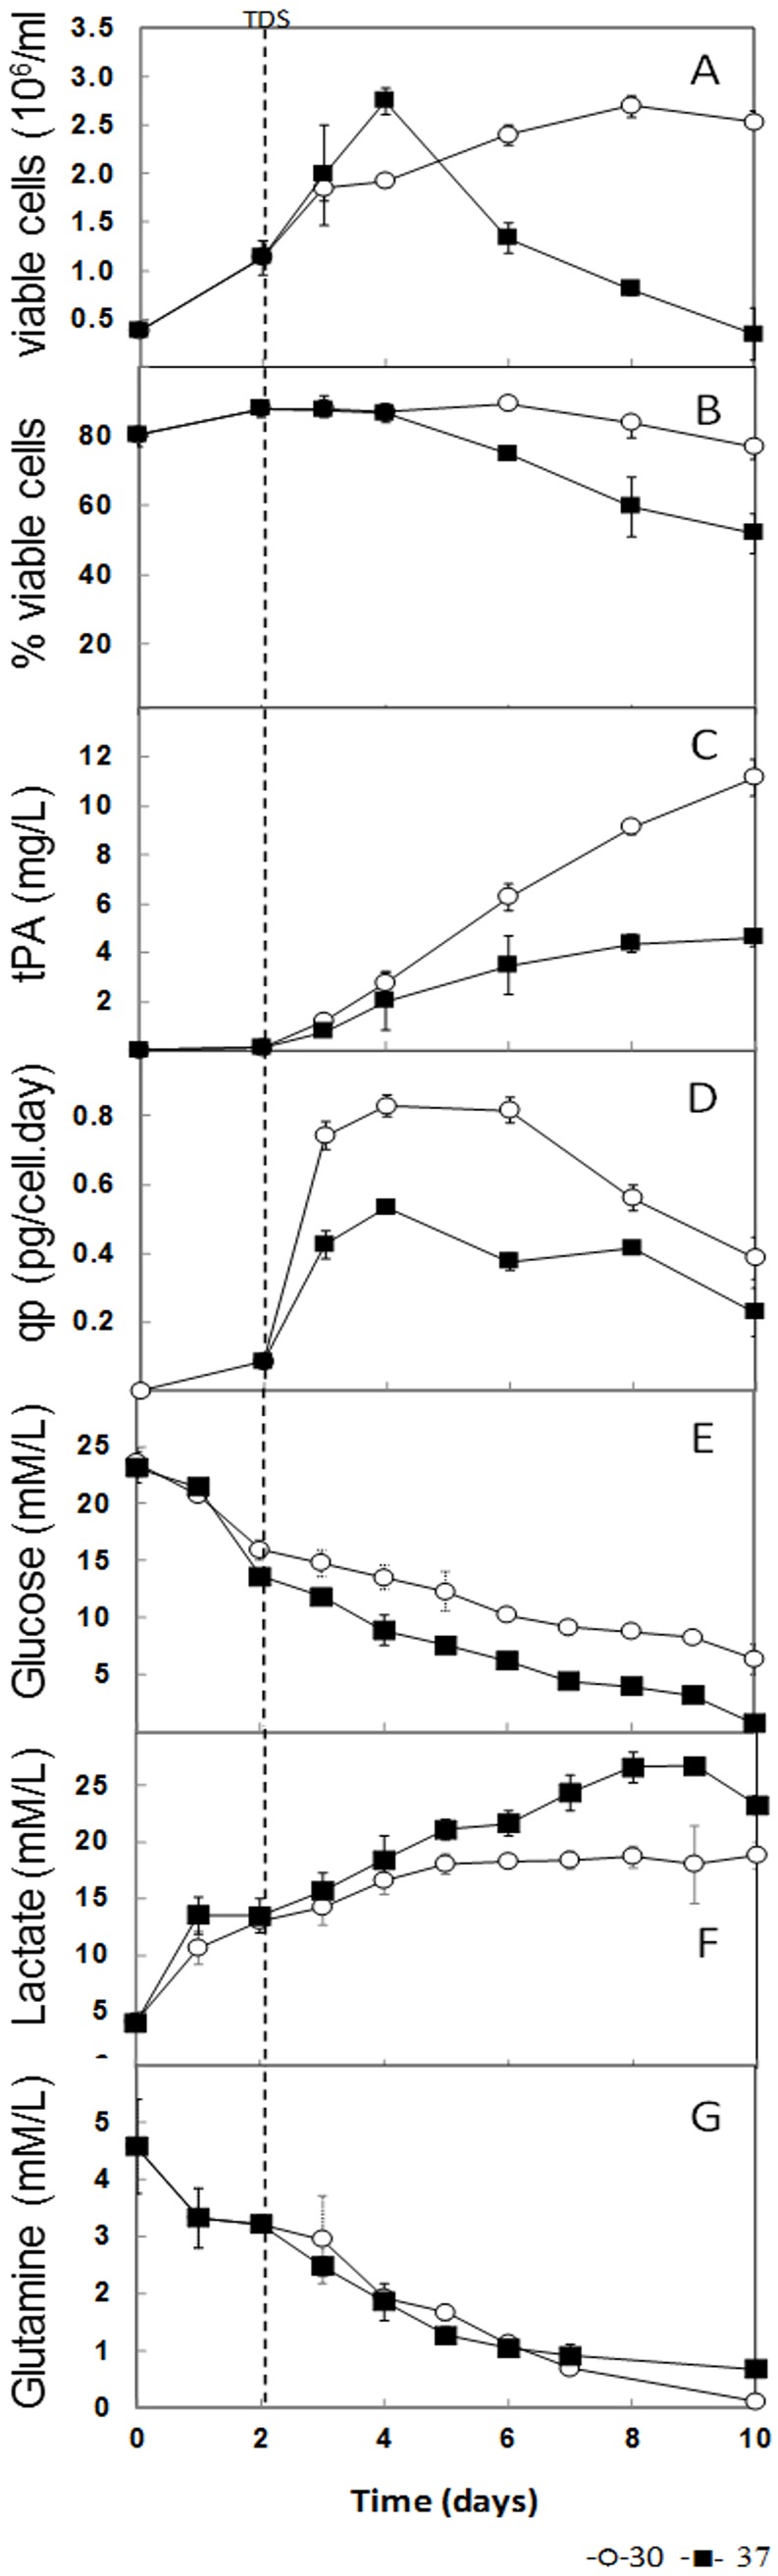
Kinetics of cell growth and rh-tPA production.Recombinant CHO TF70R viable cell density (A), percentage of cell viability (B), rh-tPA production (C), cell-specific rh-tPA production (D), glucose consumption (E), lactate production (F), and glutamine consumption (G) of cell cultures at 37°C (closed squares), and under temperature downshift (TDS) to 30°C at 48 h (open circles). Dotted line denotes TDS from 37 to 30°C, and transcriptomic samples were taken at 24 and 48 h after TDS.